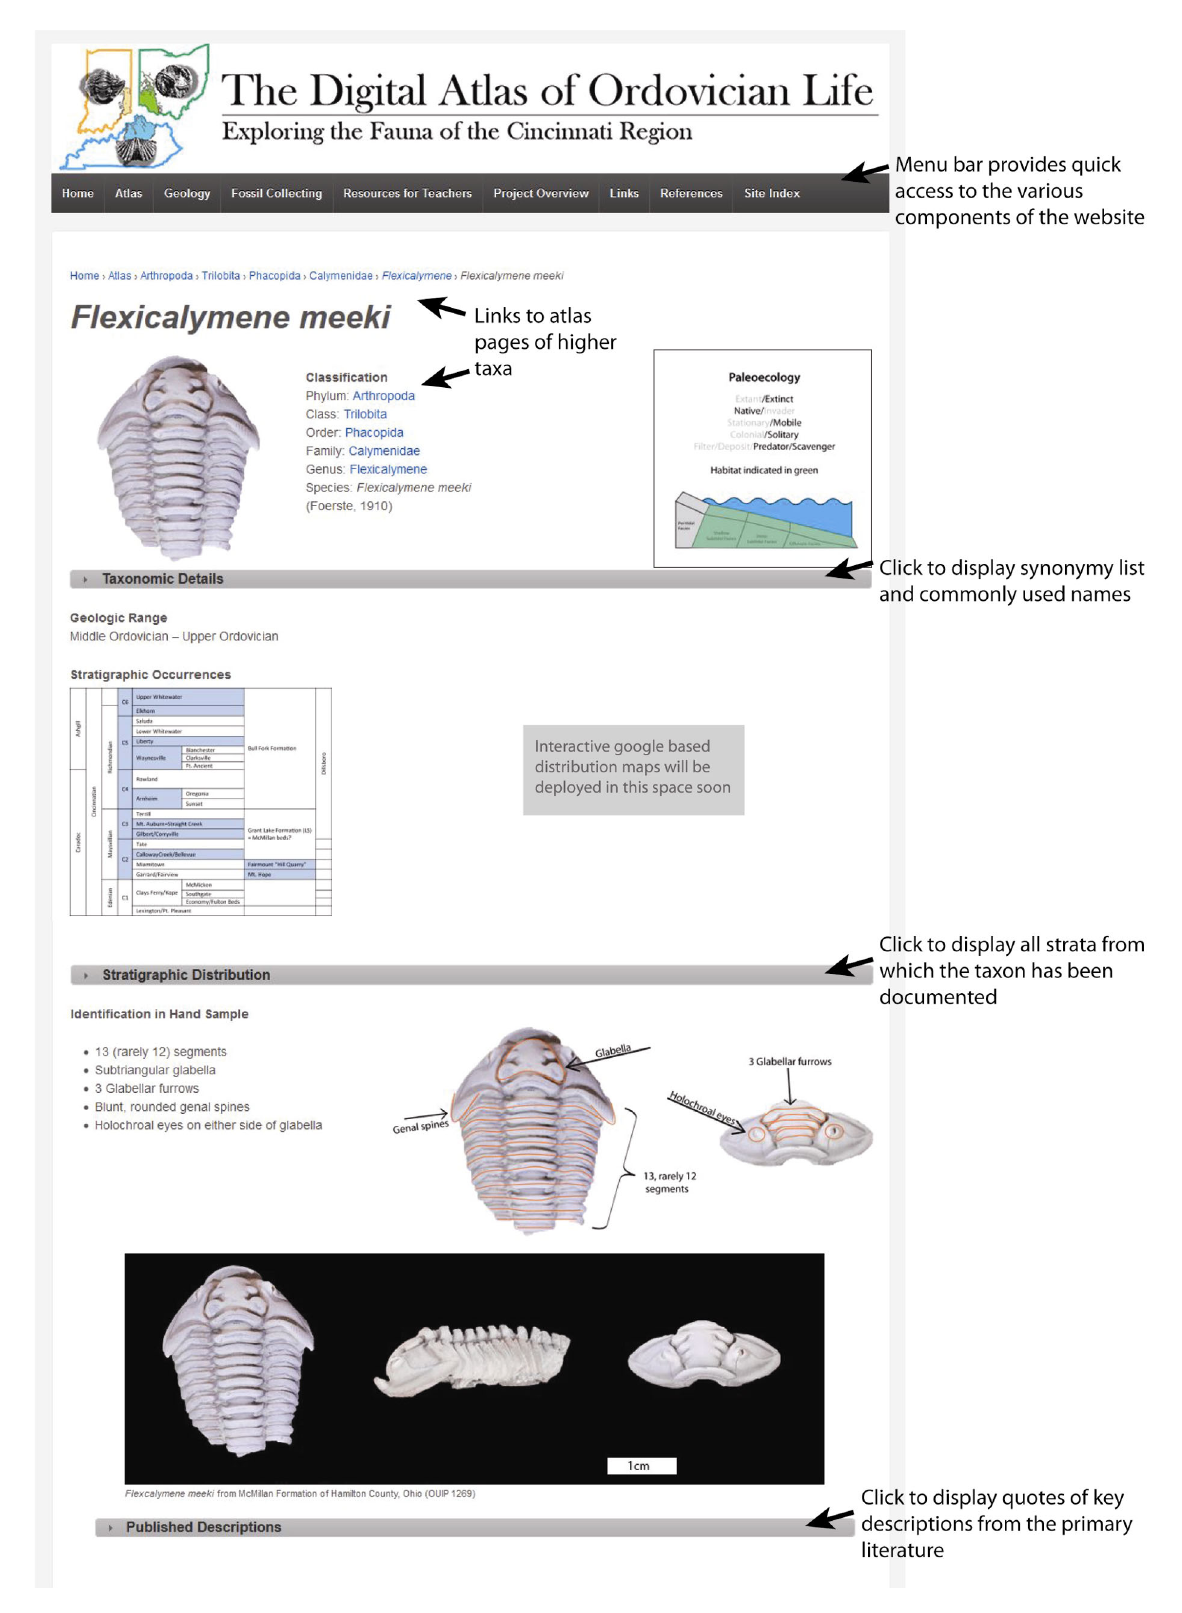
Fig. 3. Example atlas page of the calymenid trilobite Flexicalymene meeki . Key navigational features are